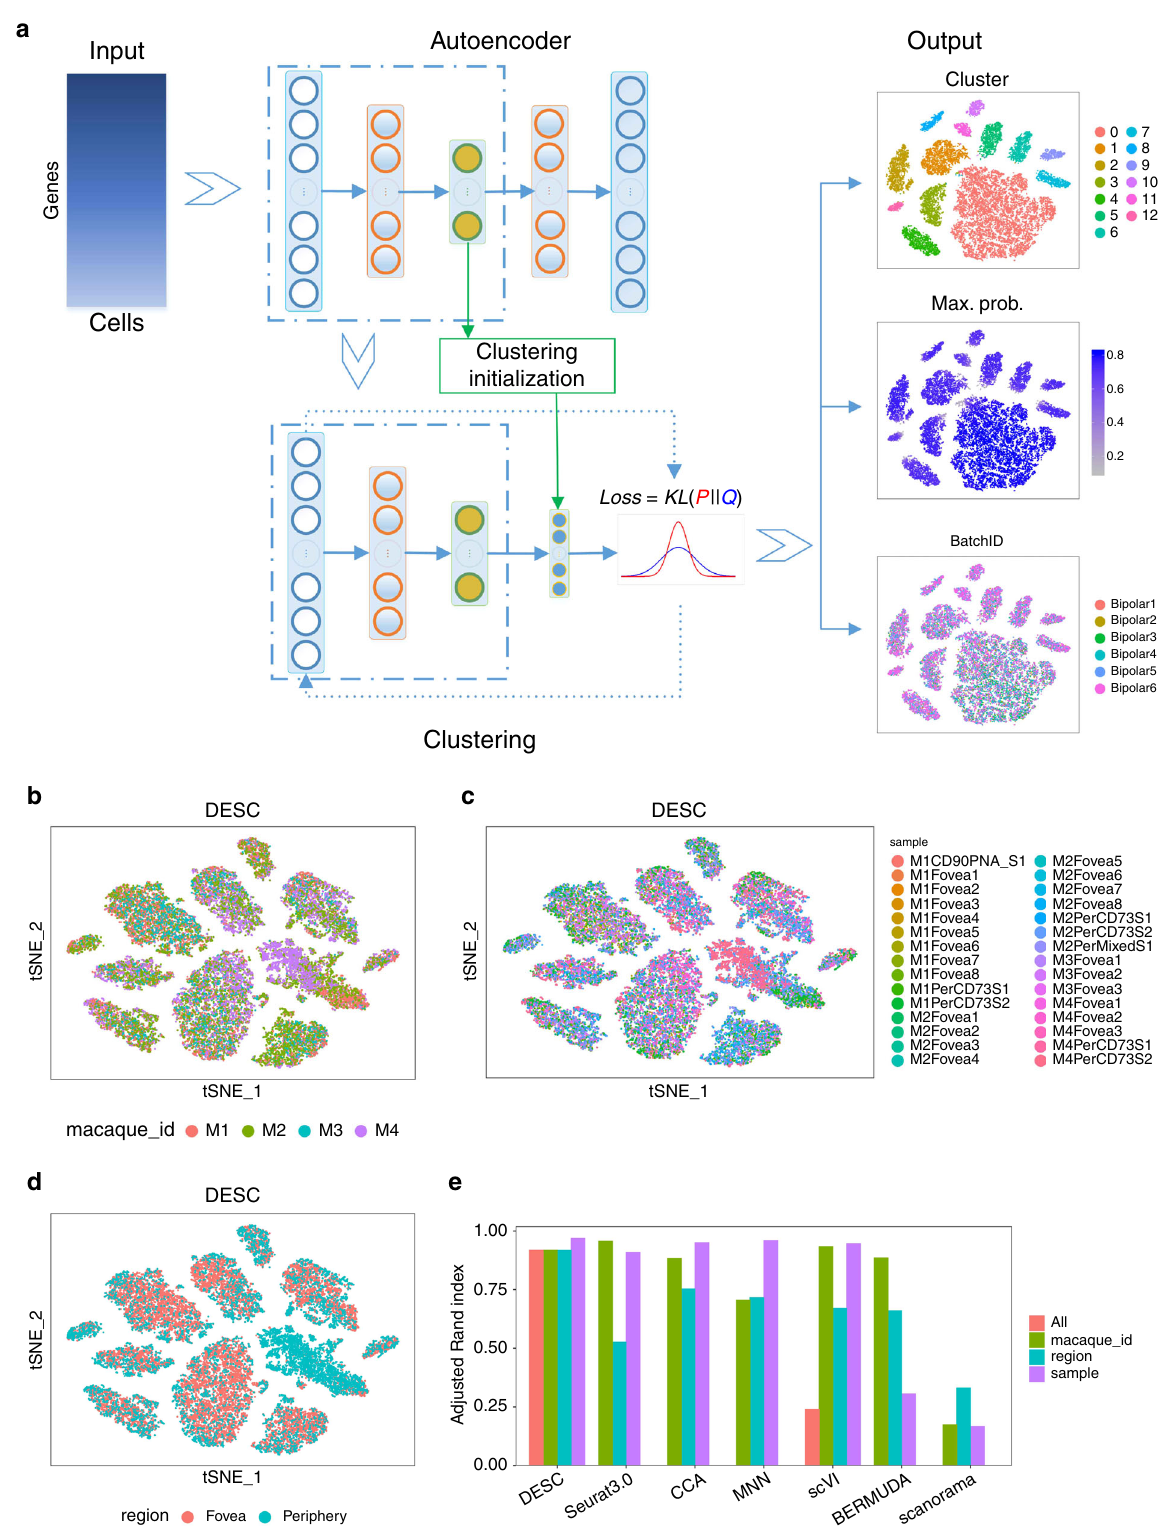
Fig. 1 The work fl ow of DESC. a Overview of the DESC framework. DESC starts with parameter initialization in which a stacked autoencoder is used for pretraining and learning a low-dimensional representation of the input gene expression matrix. The resulting encoder is then added to the iterative clustering neural network to cluster cells iteratively. The fi nal output of DESC includes cluster assignment, the corresponding probabilities for cluster assignment for each cell, and the low-dimensional representation of the data; b – d The t-SNE plots of DESC for the macaque retina scRNA-seq data generated by Peng et al. 10 The plots are colored by macaque id ( b ), sample id ( c ), and region ( d ). e The ARIs of different methods. The ARIs were calculated when taking different information (macaque id, sample id, region id) as batch in analysis, and “ All ” was calculated when no batch information was provided in